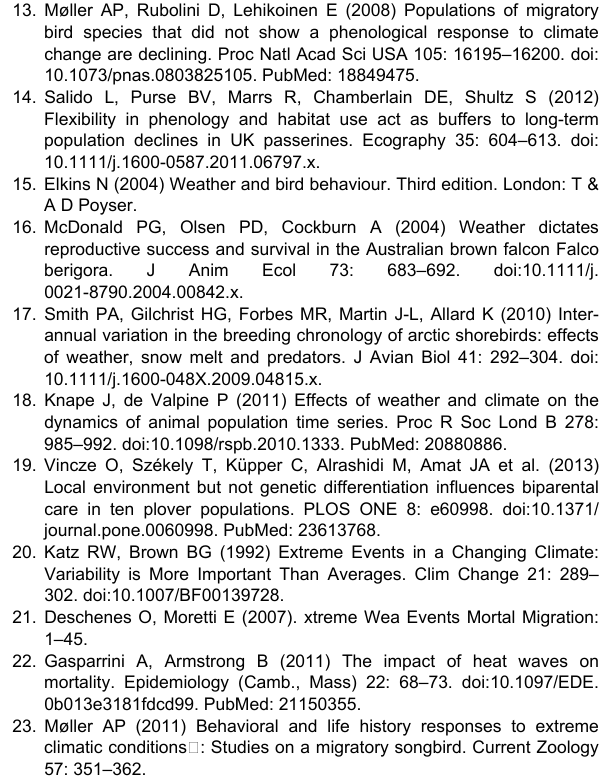
Table S3. Model set for fledging success; models with ∆AIC>2 are written in bold (n=211 nests).